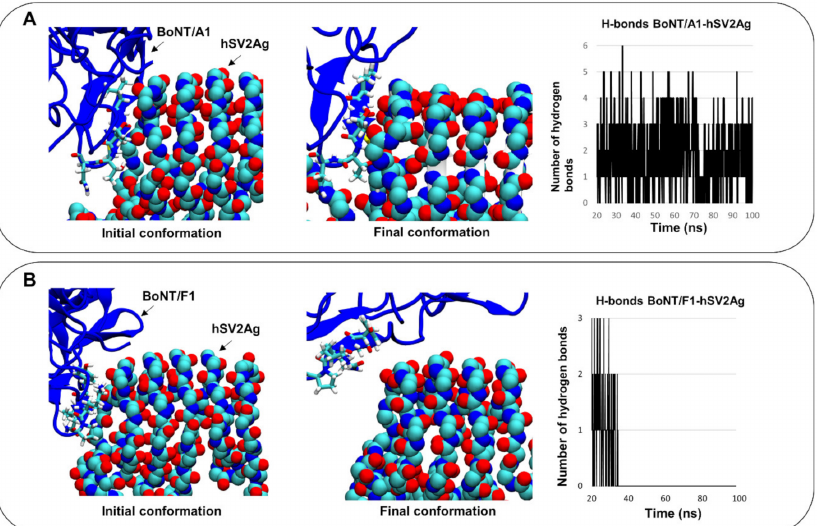
Figure 3. Molecular details of the interactions between BoNT/A1 or BoNT/F1 and hSV2Ag. Snap- shots showing the molecular details of the initial and final conformations obtained for the BoNT/A1 complex and a plot presenting the number of hydrogen bonds formed by the complex ( A ). Similar data for the BoNT/F1–hSV2Ag complex ( B ). BoNT/A1 and BoNT/F1 are depicted as the color blue, and 1141-GSVMTT-1146 in BoNT/A1 and 1130-GVYQKP-1135 in BoNT/F1 are represented as lines colored according to atom name. The backbone of the membrane receptor hSV2Ag is depicted as spheres colored according to atom name (cyan for carbon, blue for nitrogen and red for